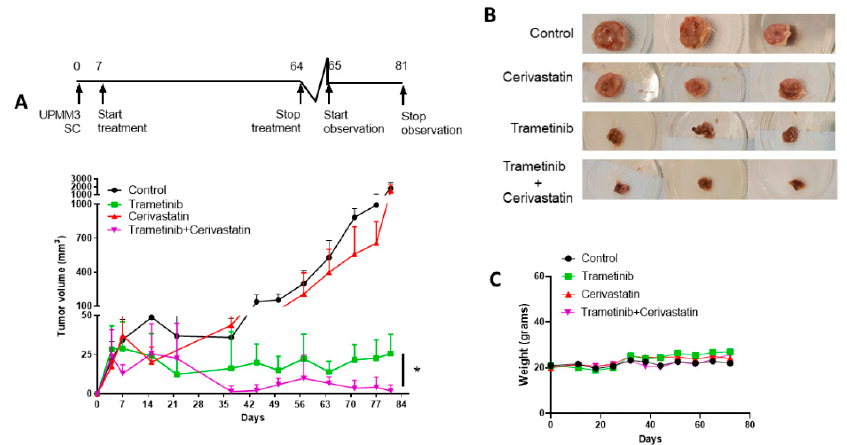
Figure 6. In vivo tumour growth of UPMM3 injected subcutaneously in NOD.Cg-Prkdc scid Il2rg tm1wjl / SzJ mice . Mice treated with vehicle alone (control, black circle), trametinib (green square),